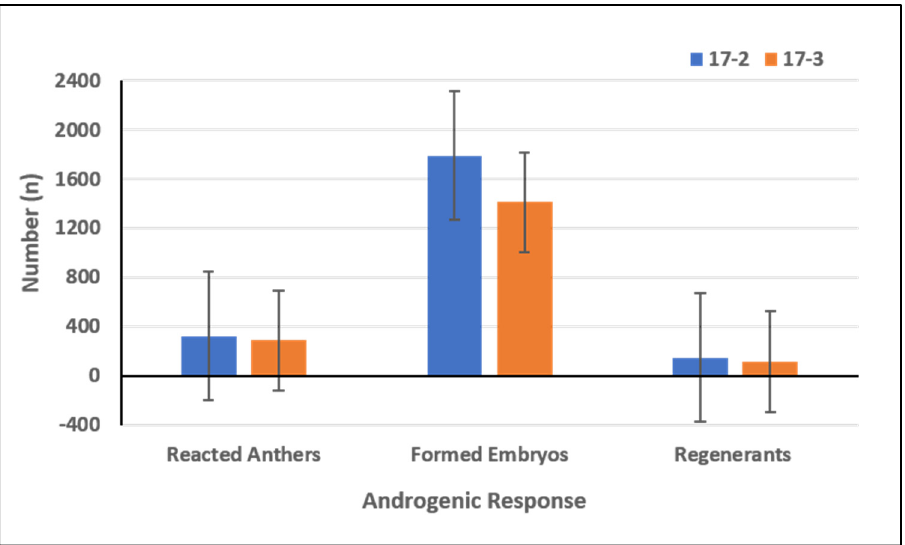
Figure 2. Effect of induction medium variants 17-2 and 17-3 on androgenic response of 180 pepper accessions.